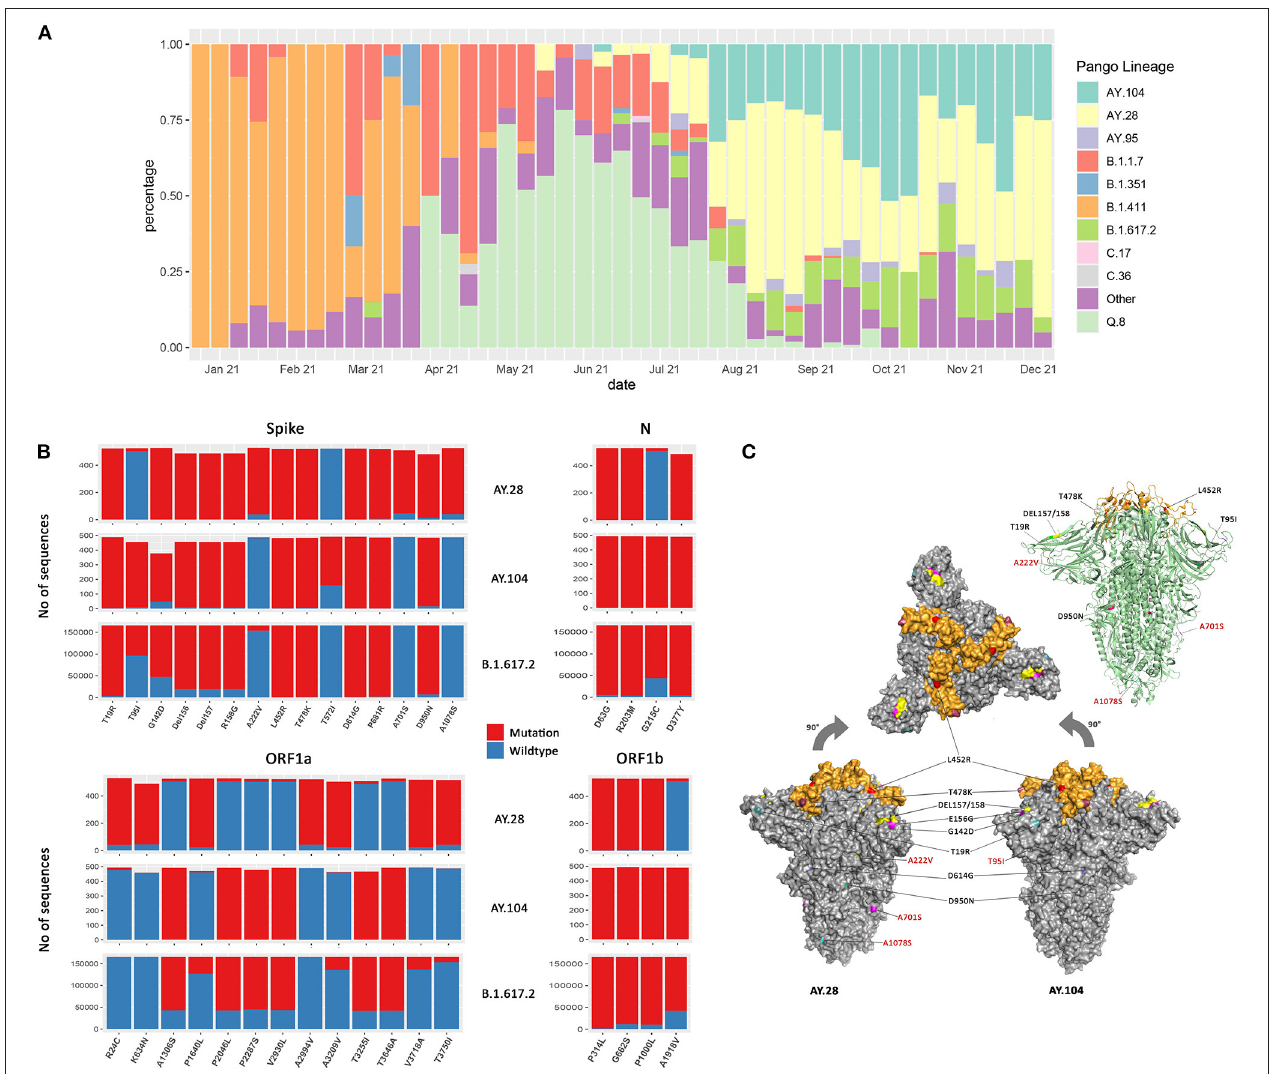
FIGURE 1 | The mutation and structural changes of AY.28 and AY.104 sequences in comparison with B.1.617.2 (Delta) lineage. (A) Weekly lineage frequencies of the sequenced cases in Sri Lanka since January 2021 were retrieved from the GISAID EpiCoV database. (B) The frequency of mutations in the spike, ORF1a, ORF1b, and N proteins of AY.28 and AY.104 compared to those of the parental B.1.617.2 (Delta) lineage. The bar height represents total unambiguous amino acids at each position, mutated (red) and wildtype (blue) based on the analysis of the global sequences deposited in the EpiCoV database. (C) The structural modeling of the pre-fusion surface representation of the SARS-CoV-2 B.1.671.2 spike trimer (PDB: 6ZGE) and the mutations in the structure in AY.28 and AY.104 are shown. The receptor-binding domain (RBD) is colored in orange while the N-terminal and S2 subunit are shown in gray. Amino acid substitutions and deletions are colored on the surface and labels of the mutations specific for AY.28 and AY.104 are colored in red. On the right, a ribbon diagram is shown of the